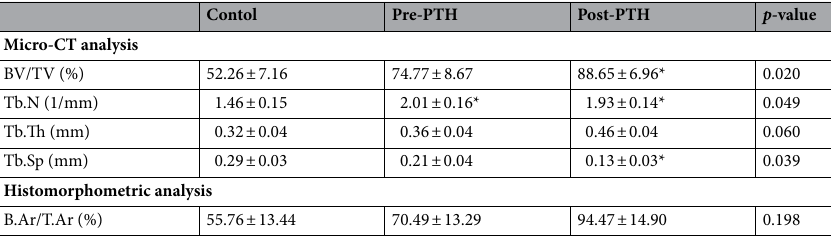
Table 2. Effects on the extraction socket healing related to parathyroid hormone (PTH) administration (The actual data of Fig. 1). BV/TV bone volume/tissue volume, Tb.N trabecular number, Tb.Th trabecular thickness, Tb.Sp trabecular separation, B.Ar/T.Ar bone area/tissue area. * p < 0.05, versus the